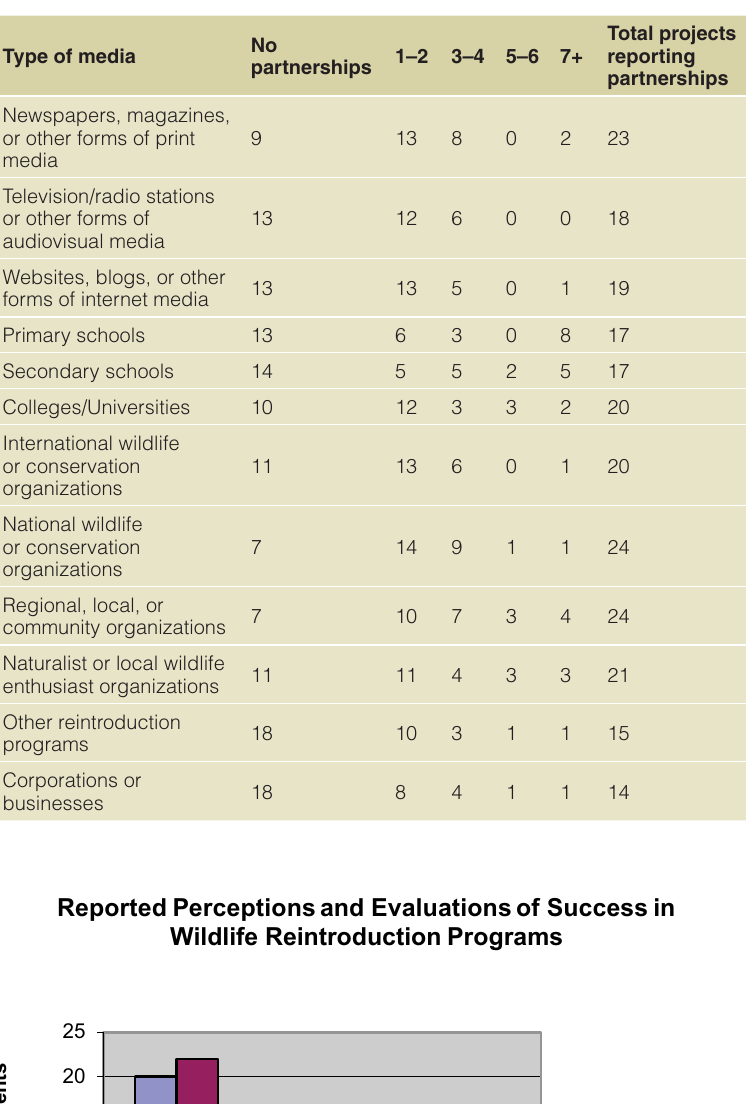
Table 1. Reported partnerships of wildlife reintroduction programs.